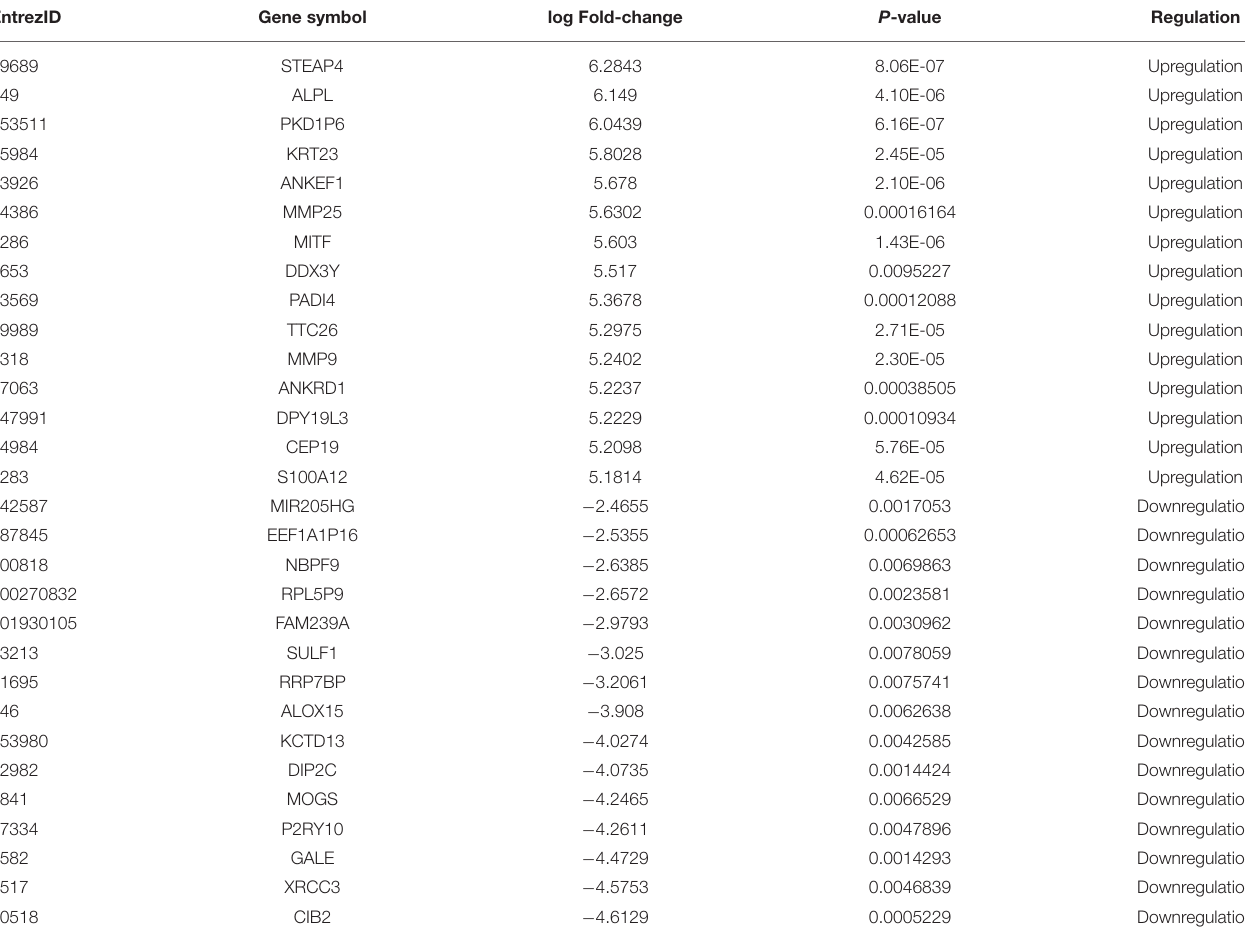
TABLE 2 | The top 15 upregulated and top 15 downregulated exosomal mRNAs in AMI group compared with the control group.